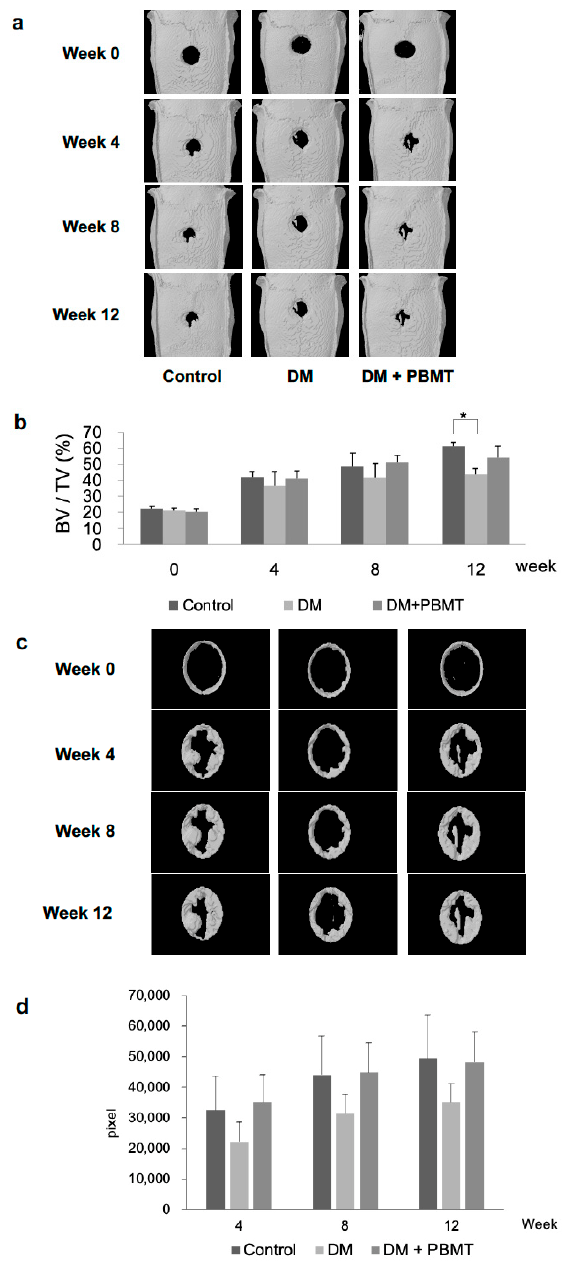
Figure 2. MicroCT analysis of in vivo calvarial bone repair at week 12 post-operation. ( a ) Represen- tative microCT images of calvarial bone sections from each group: Control, DM, and DM + PBMT treatment. Calvarial bone defects (3 mm) were generated in adult Wistar rats and PBMT treatment (4 J/cm 2 ) was applied daily. The follow-up imaging and analyses were performed at Weeks 0, 4, 8, 12 postoperatively to quantify residual defect volume and new bone formation. ( b ) Quantitative measurements obtained from microCT images. The data illustrated as the percentage of bone volume (BV) per total volume (TV) of the calvarial defect and expressed as means ± SD, * p < 0.05. ( c ) Rep- resentative microCT images of calvarial bone matrix formation at Weeks 0, 4, 8 and 12 from each group: Control, DM, and DM + PBMT treatment. Calvarial bone defects (3 mm) were generated in adult Wistar rats and PBMT treatment (4 J/cm 2 ) were applied daily. The close-up imaging on the calvarial defect sites were performed to evaluate new bone matrix formation at Weeks 0, 4, 8, 12 postoperatively. ( d ) Quantitative measurements obtained from microCT images of the calvarial bone matrix formation at Weeks 0, 4, 8 and 12. The data is illustrated as the density measurements from the pixel mapping of the region of interest (ROI) and expressed as means ±